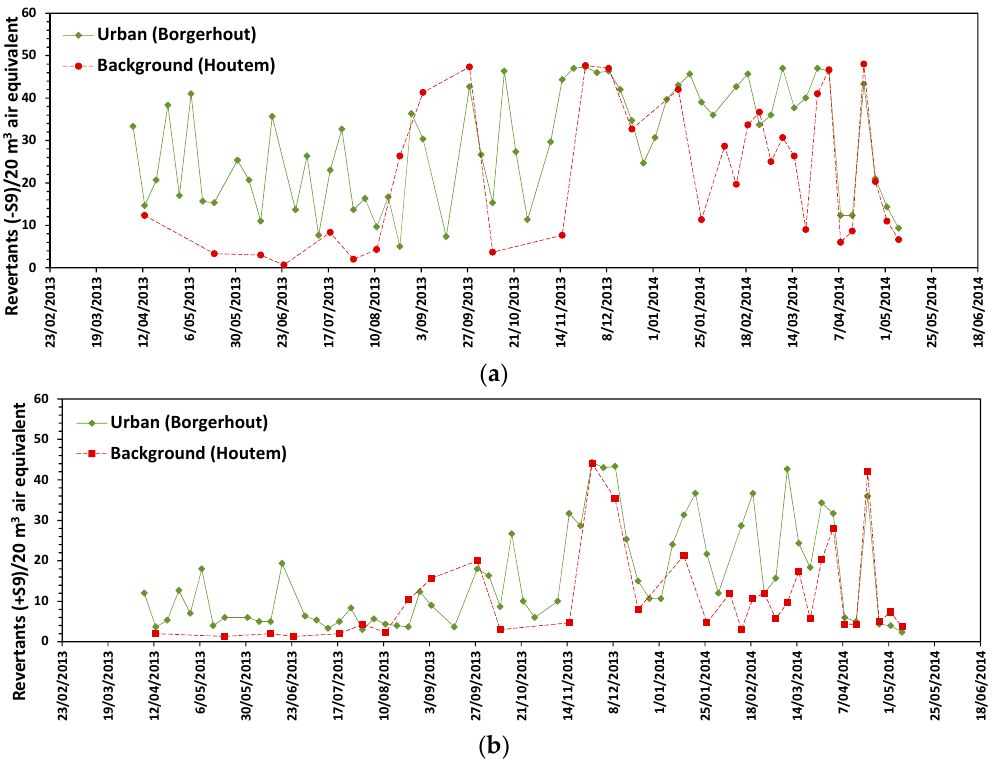
Figure 3. Time series of direct ( a ) and indirect ( b ) mutagenic potential of individual PM 10 air samples between April 2013 and May 2014 for each sampling site. The mutagenic potency of each ASE-extract was tested at a concentration of 20 m 3 air equivalent. Mutagenicity is expressed as the number of revertants counting/plate. Values represent mean of 3 replicate wells.